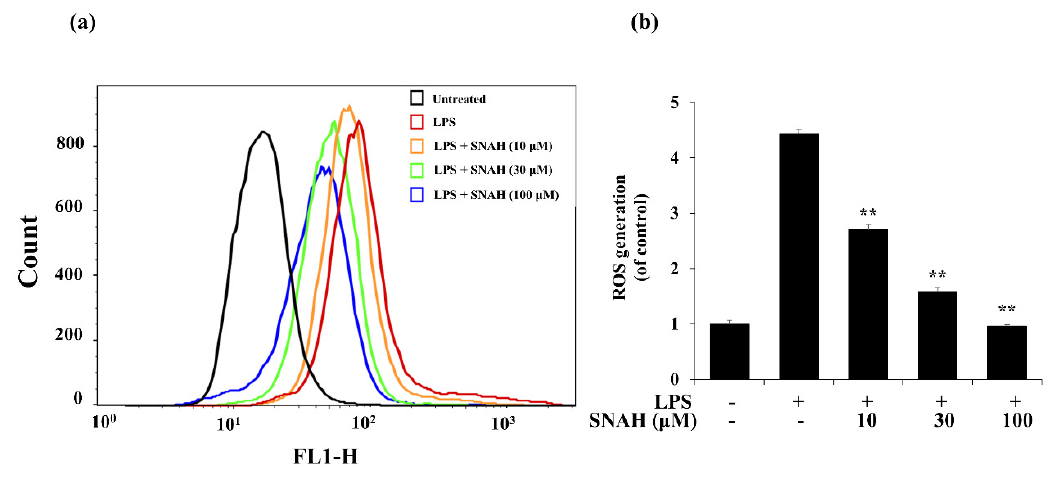
Molecules 2018 , 23 , x 5 of 15 Figure 4. Effect of SNAH on TNF- α , iNOS, and IL-6 gene expression in RAW 264.7 cells. RAW264.7